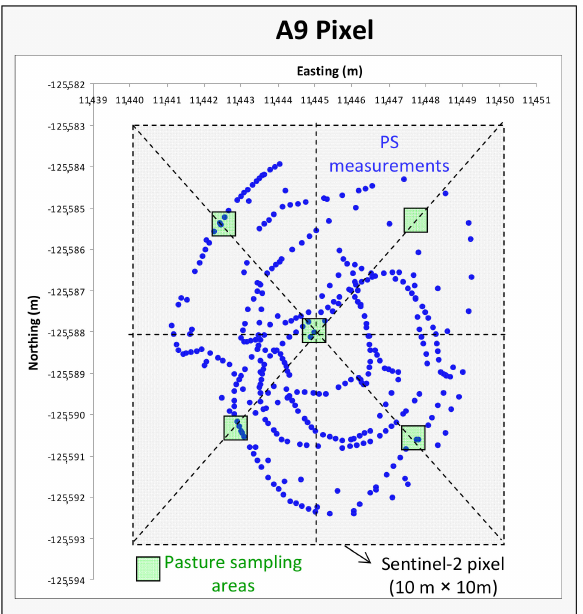
Figure 5. Sampling areas (e.g., A9 Pixel): (i) Sentinel-2 pixel; (ii) proximal sensing (PS); and (iii) field pasture